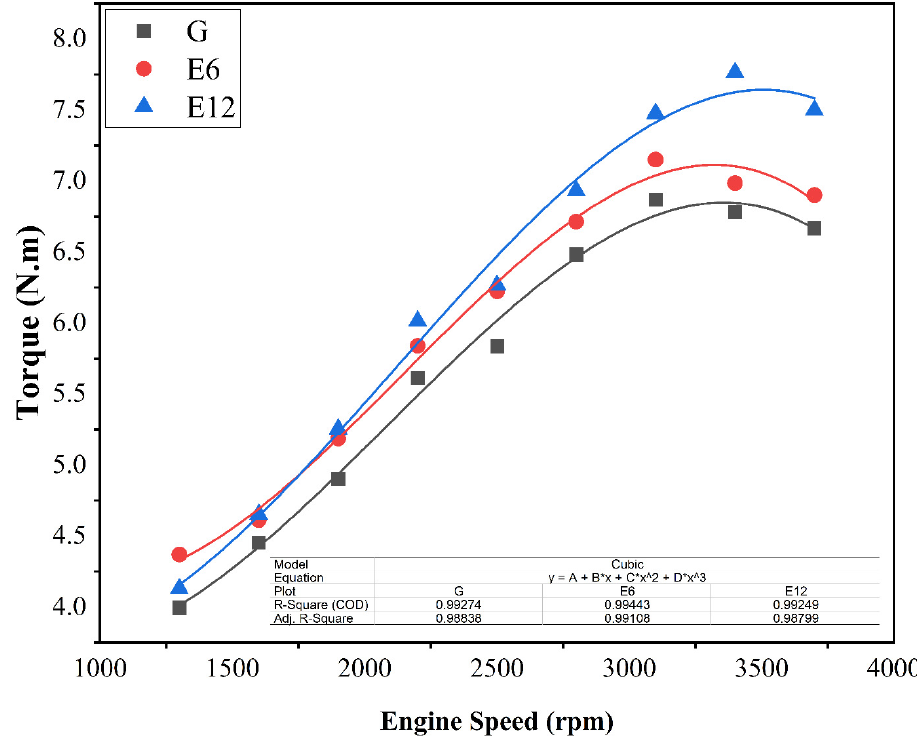
Figure 2. Torque variation with engine